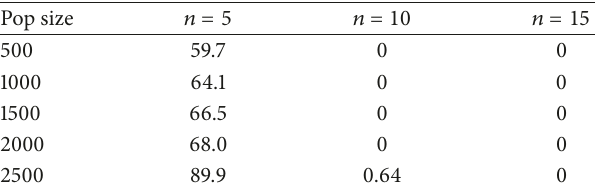
Table 3: Percentage of PDS in the final population for the single population approach on 𝑀 = 4 .